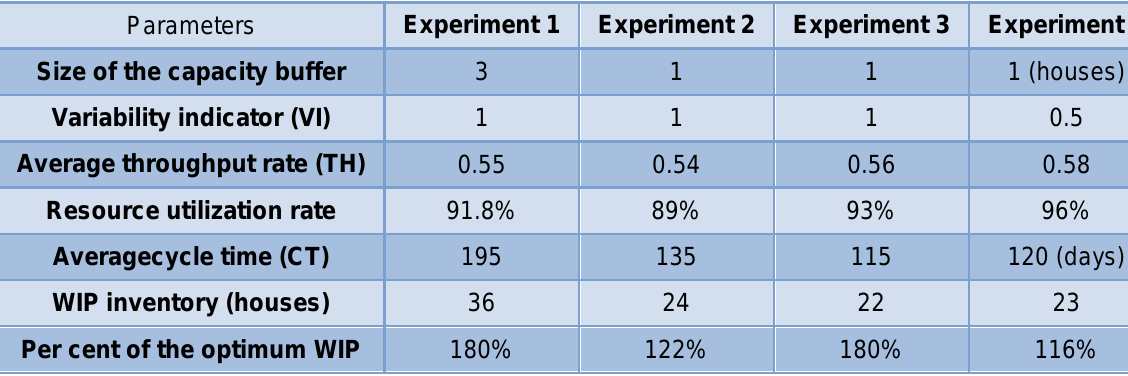
Table 2 Performance measures of the volume homebuilding network in the four simulation experiments